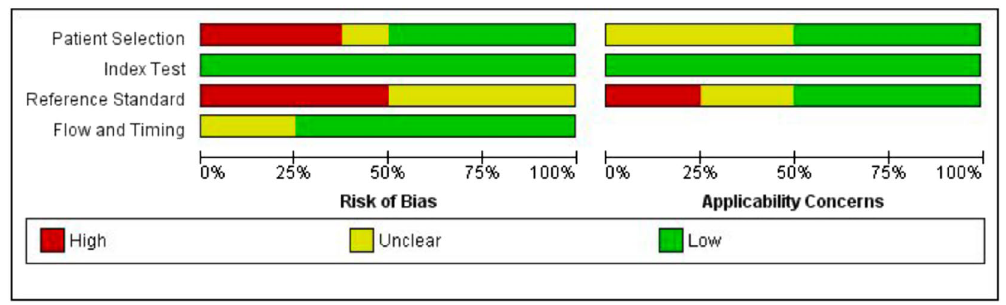
Figure 2. Risk of bias and applicability concerns